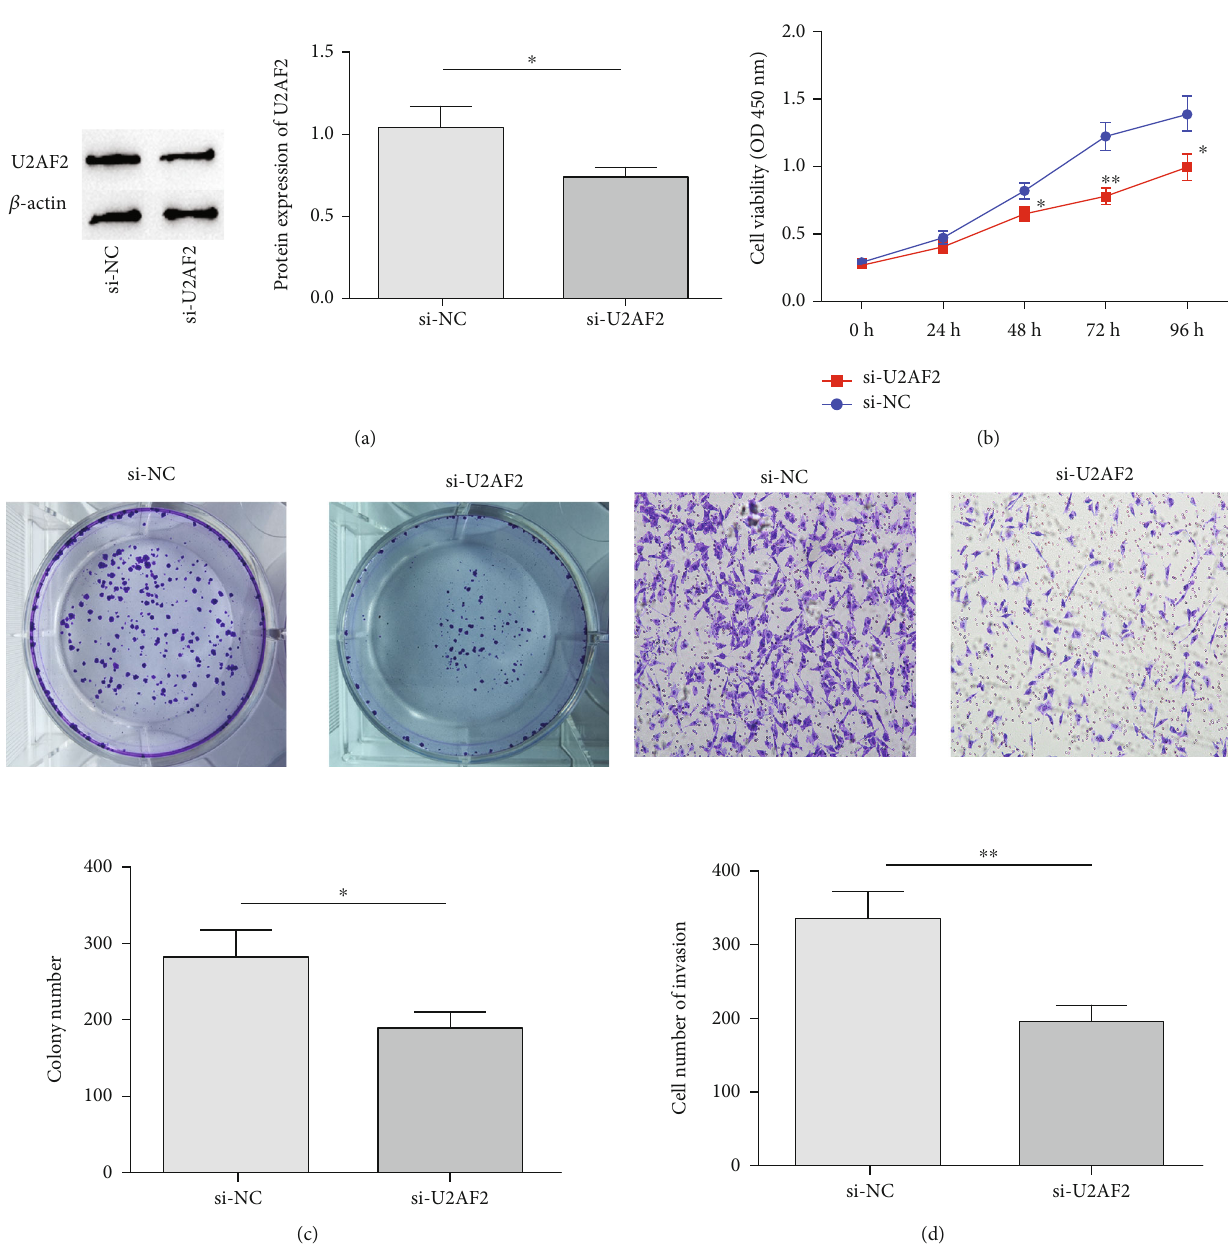
Figure 5: Impact of U2AF2 on biological function of PC cells. (a) U2AF2 expression; (b) cell viability detection; (c) plate clonal cell formation; (d) cell invasiveness; ∗ P < 0 : 05 ; ∗∗ P < 0 : 01